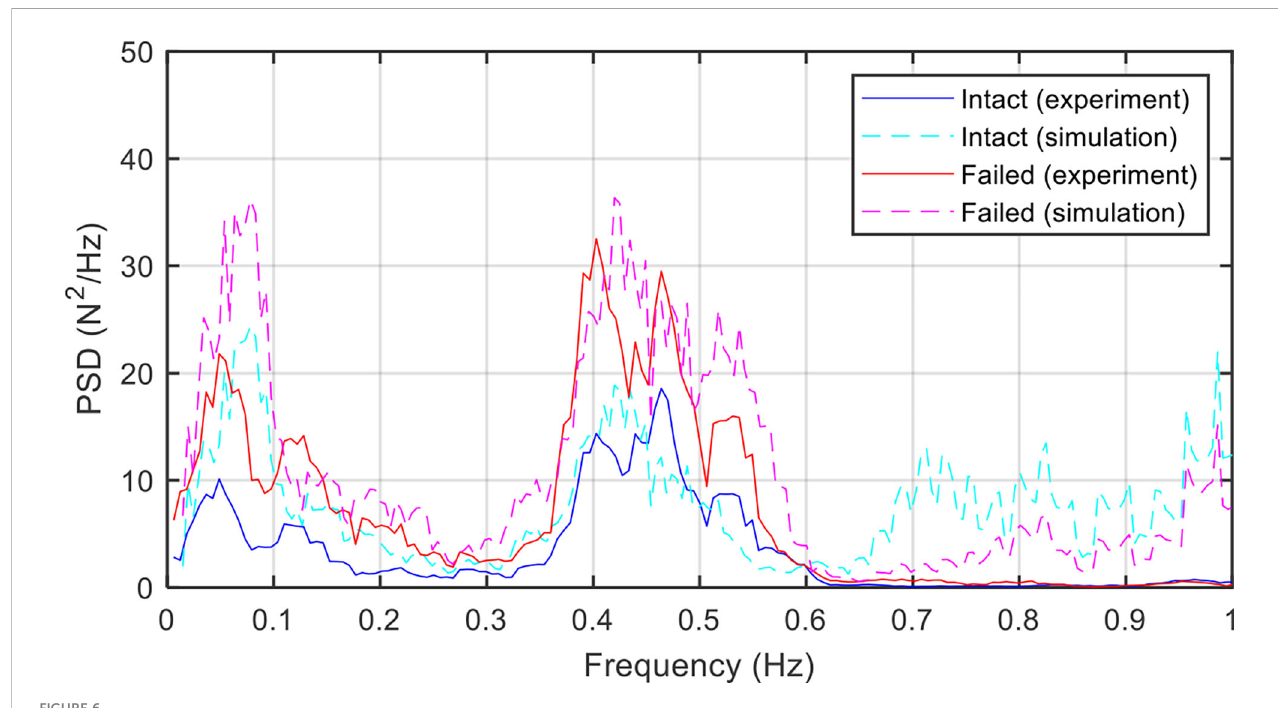
FIGURE 6 Power spectral density of the mooring tension in Line